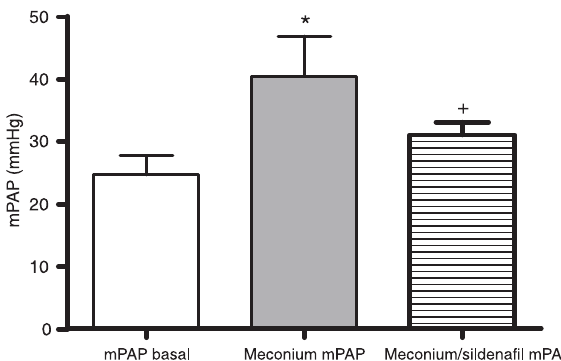
Figure 3. Mean pulmonary arterial pressure (mPAP) in three different situations: basal, after meconium aspiration and after meconium aspiration plus treatment with 2 mg/kg sildenafil. Data are reported as means ± SD. Group comparisons demonstrated an increase in PAP when comparing meconium aspiration to bas - al data and prevention of the PAP increase after administration of sildenafil. *P < 0.001 compared to basal; + P < 0.001 compared to meconium (Student t -test).